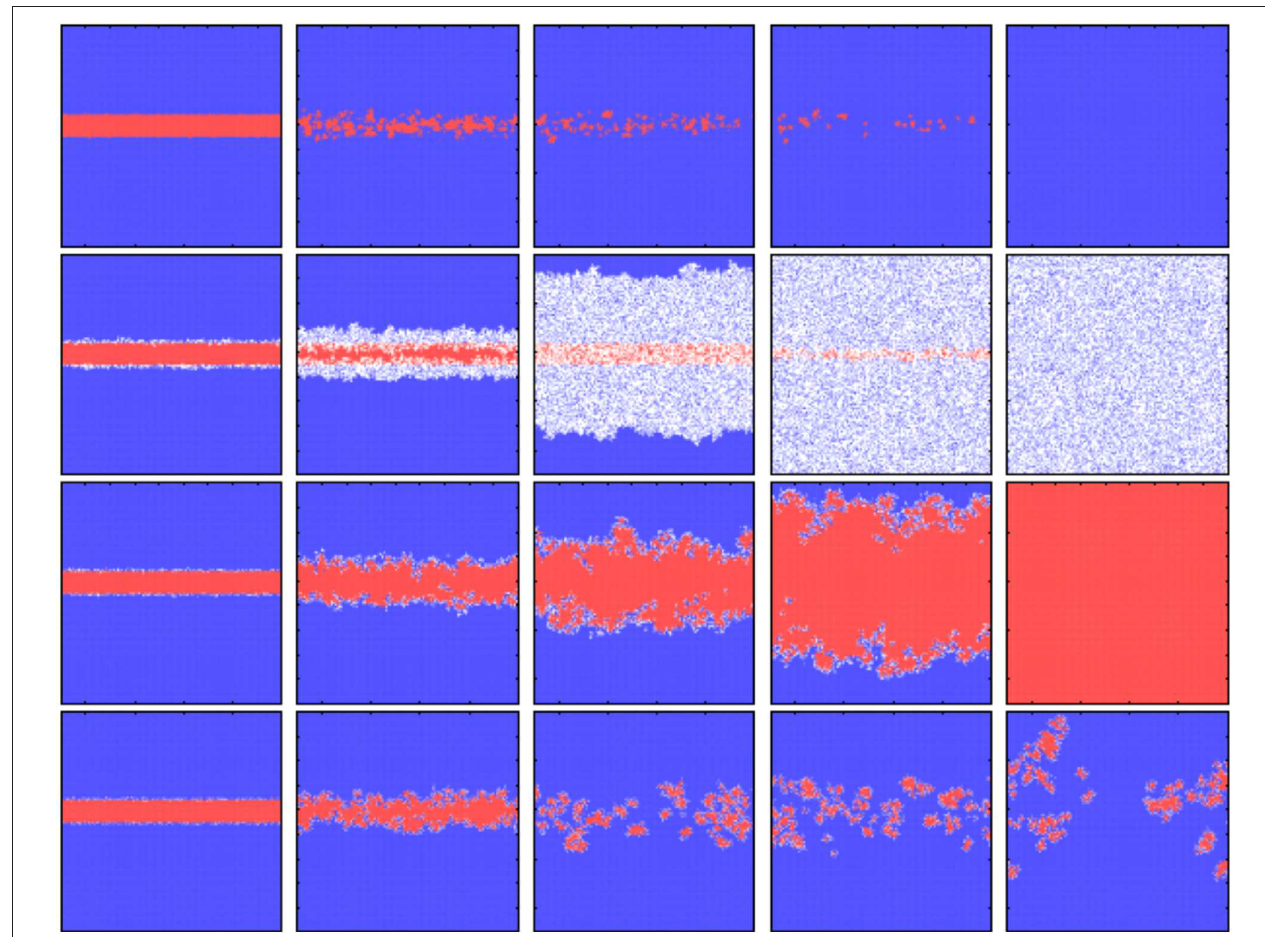
FIGURE 4 | Evolutionary snapshots reveal how inactive players affect the cooperative dynamics. Top row presents the traditional case, where the exit option is excluded from the model. To illustrate the role of inactive players on the evolutionary dynamics, the exit cost γ were set to 0, 3, and 10 from the second to the bottom row. From left to right, snapshots are obtained at different MC steps. Cooperators, defectors, and inactive players are denoted by red, blue, and white, respectively. The parameter combinations are b = 1.07, K = 0.1, L =